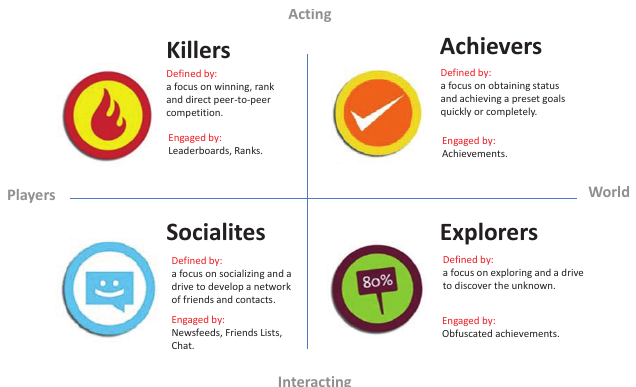
Fig. 1. Bartle’s Player Types (Bartle, 1996).